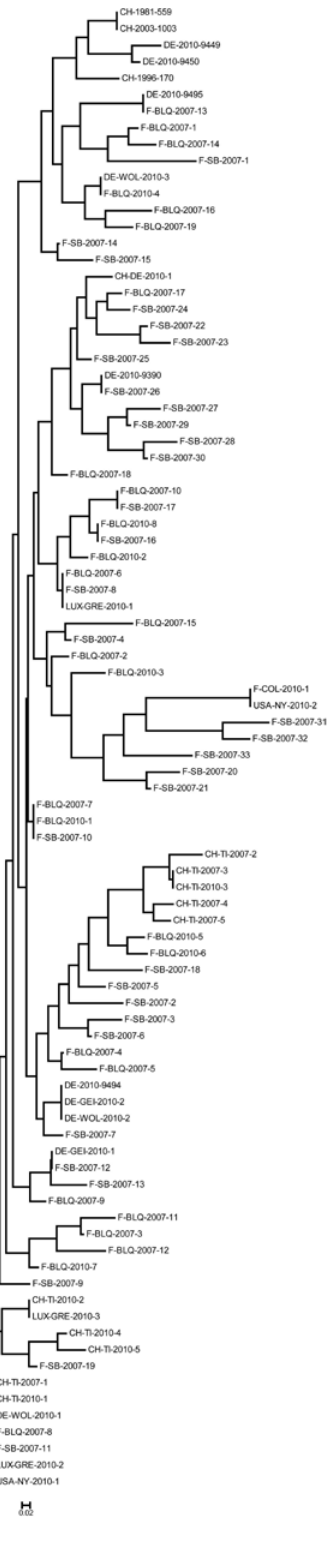
Figure 1. Neighbour-joining genetic tree of Phyllosticta ampelicida individuals gener- ated using the POPULATIONS software, calculating distances according to Nei et al. (1983), with bootstrap values from 500 repetitions. Samples were grouped in popula - tions according to region of sampling. Environmental samples are coded by country, region, collection year and a number assigned to the genotype. Isolates are coded by country and collection year, the isolate codes corresponding to those in Table 1. Coun- tries: CH, Switzerland; F, France; DE, Germany; LUX, Luxembourg; USA, United States. Regions, TI, Southern Switzerland; DE, Northern Switzerland; BLQ, Blanque - fort; COL, Colmar; SB, Salleboeuf; GRE, Grevenmacher; WOL, Wolf; NY, New